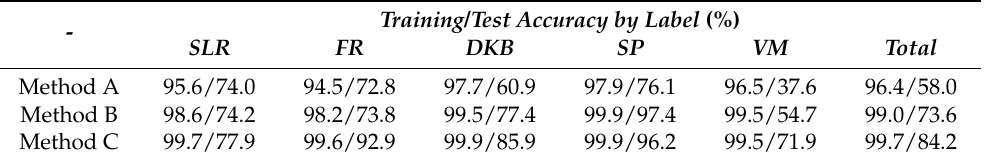
Figure 9. Dumbbell exercises: ( a ) side lateral raise (SLR), ( b ) front raise (FR), ( c ) dumbbell kickback (DKB), and ( d ) shoulder press. Table 5. Comparison of training and test accuracy of the floating body-fixed frame method over methods A and B for the dumbbell exercises.